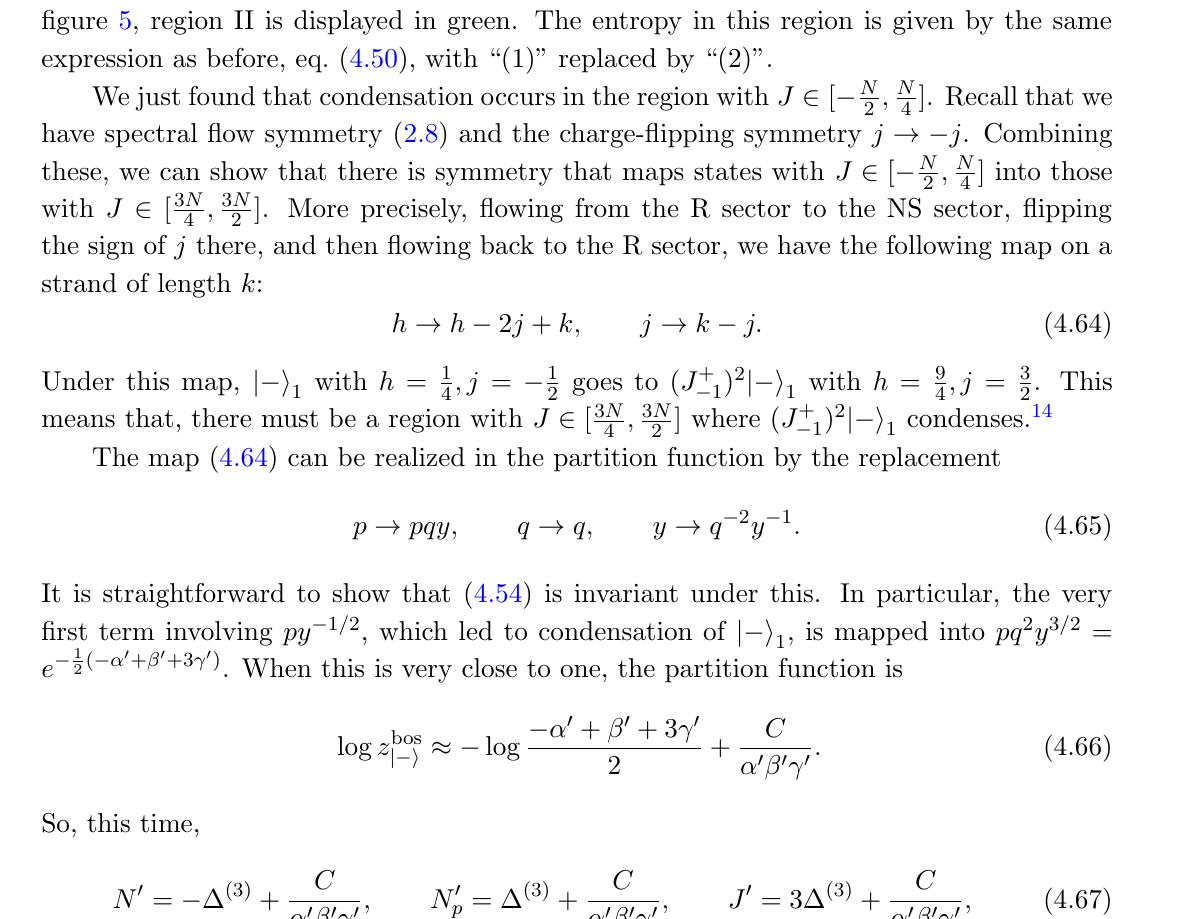
Figure 5 . The regions in which states that are counted by z bos given by (4.63), the strand j(cid:0)i condenses and (cid:1) (2) > 0. In the red region, which is given by (4.73), 1 the strand ( J + ) 2 j + i condenses and (cid:1) (3) > (cid:0) 1 1